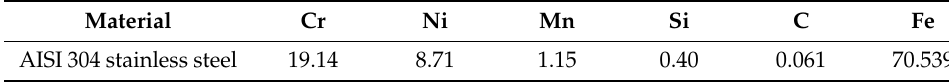
Table 1. Chemical composition of base metal (wt.%).